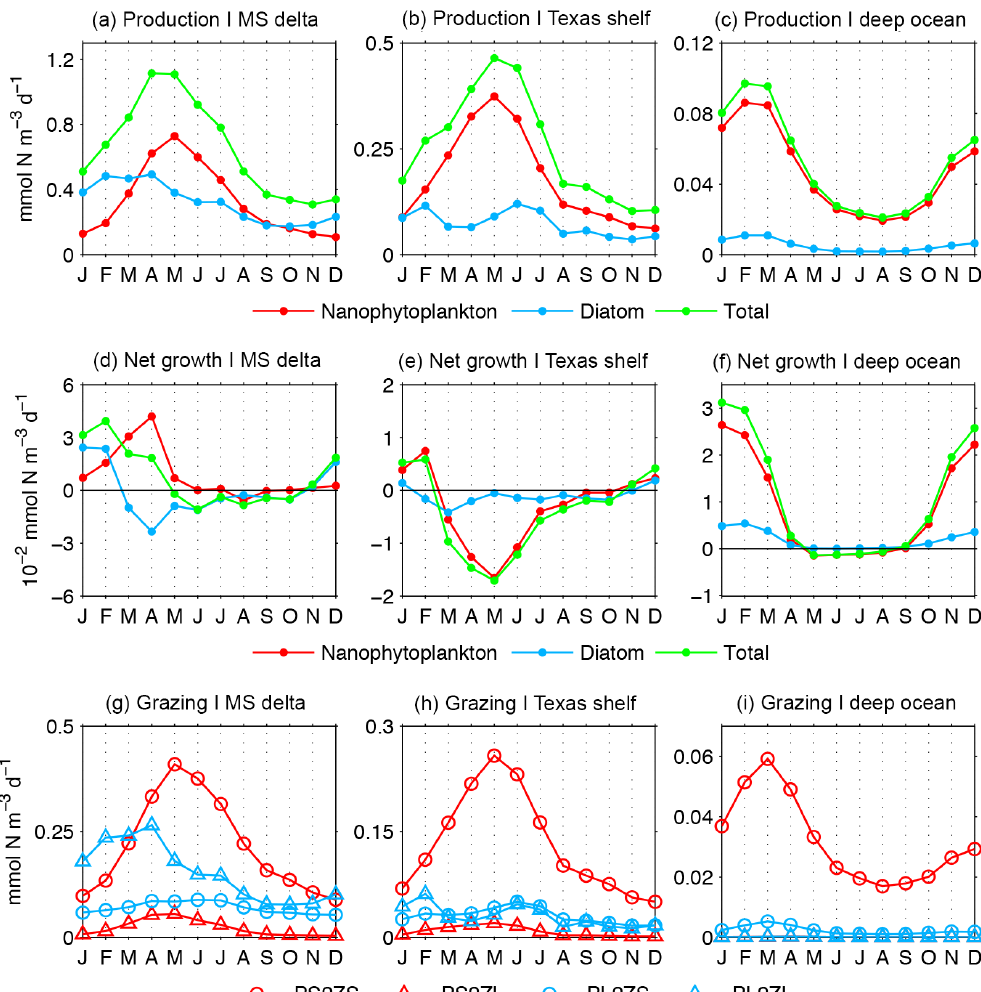
Figure 11. Phytoplankton production, net phytoplankton growth (production minus biological losses), and grazing estimated for the upper 30m layer of the Mississippi delta (a, d, g) , Texas shelf (b, e, h) , and deep ocean (c, f, i) (regions depicted in Fig. 1, gray polygons). Graz- ing terms are microzooplankton upon nanophytoplankton (PS2ZS) and diatoms (PL2ZS), and mesozooplankton upon nanophytoplankton (PS2ZL) and diatoms